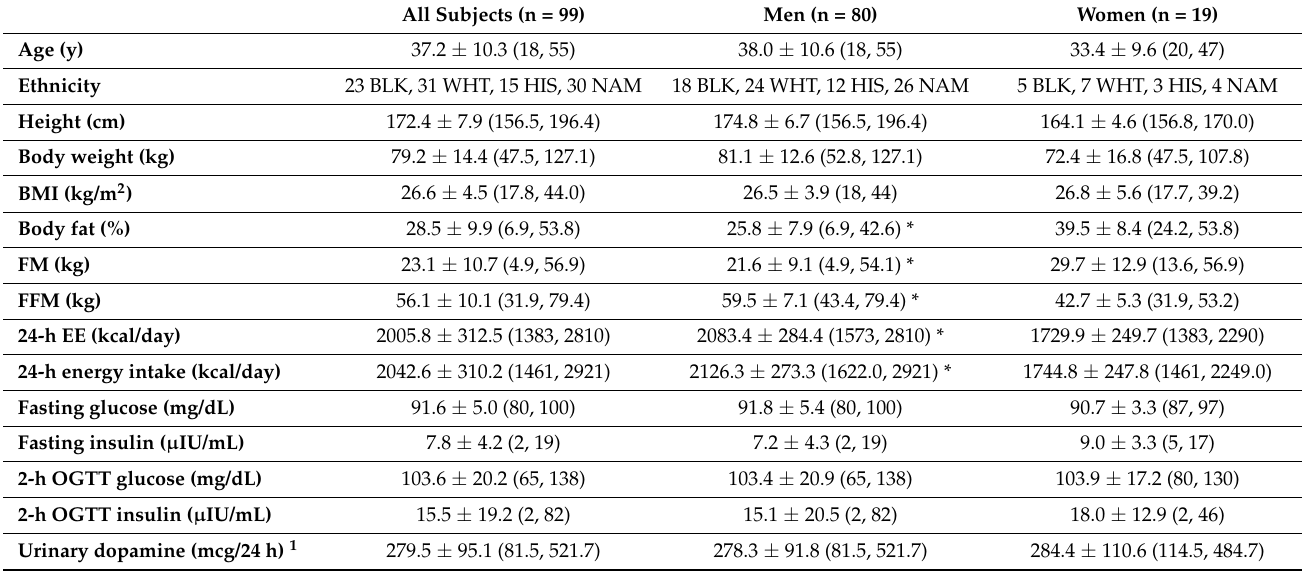
Table 1. Clinical characteristics of the study group.